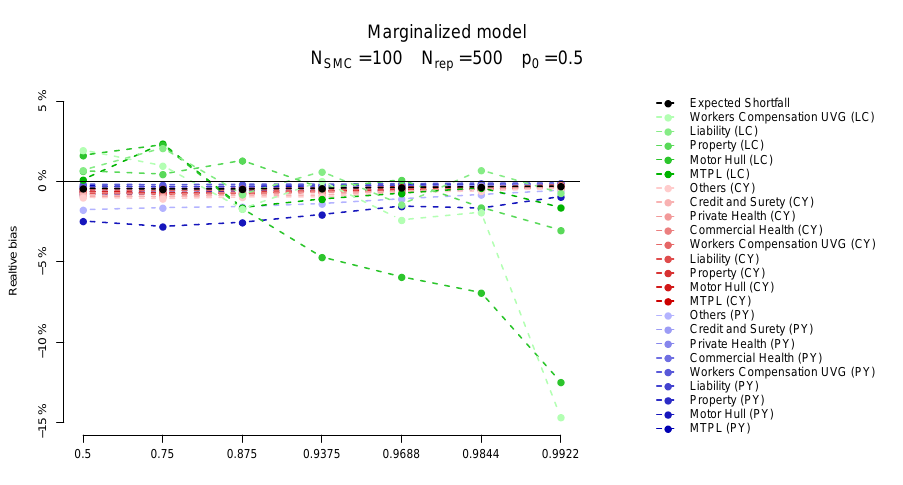
Figure 8. Histograms levels used in the Sequential Monte Carlo (SMC) sampler algorithm with p 0 = 0.5 in the conditional model. The red dashed bar represents the true value of the α quantile.